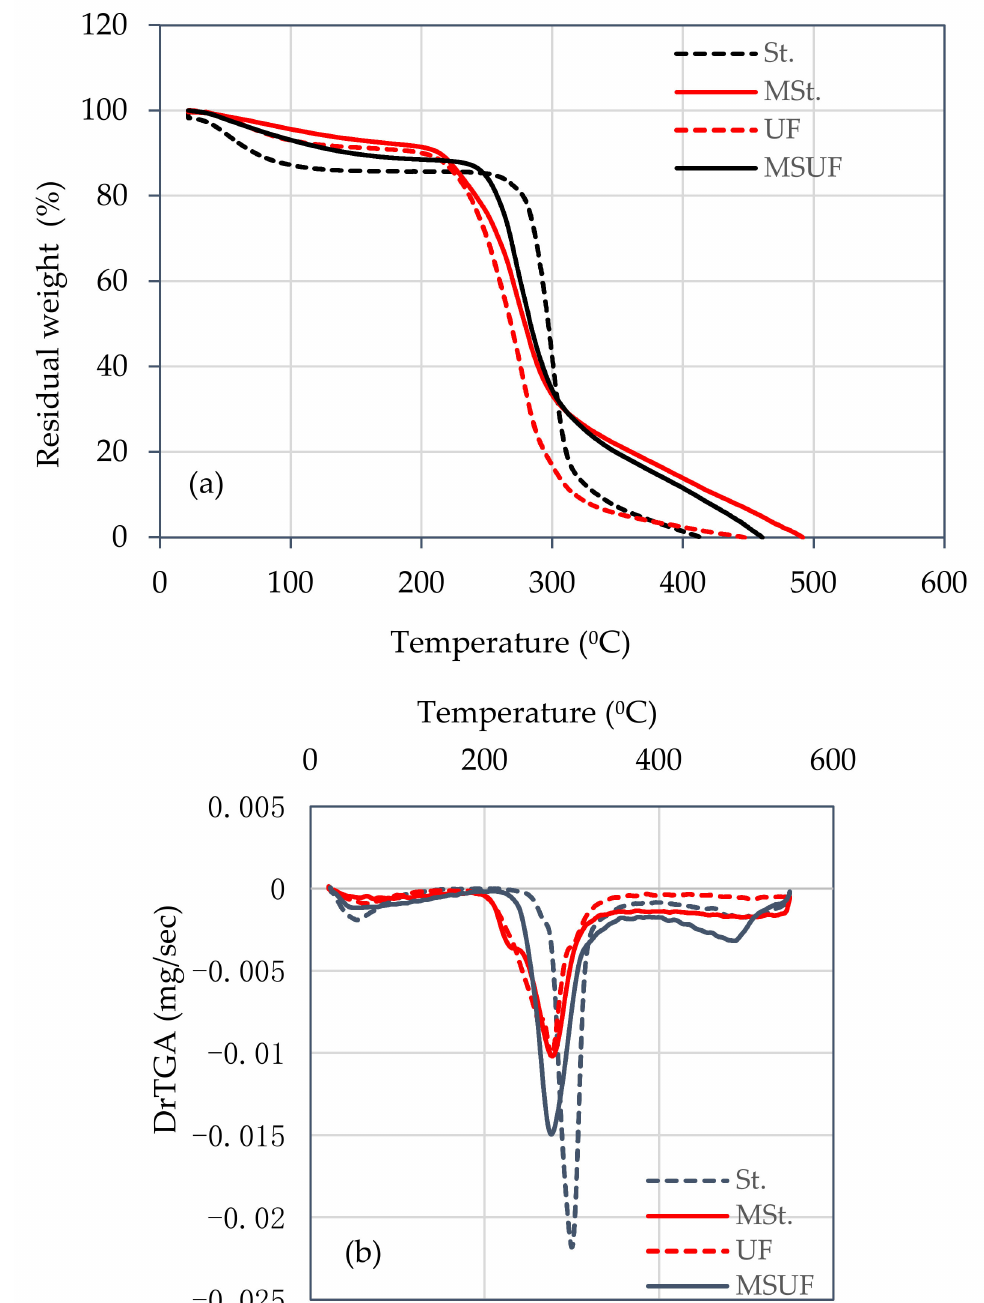
Figure 3. TGA ( a ) and DTG ( b ) curves of natural starch (US), modified starch (MS), UF resin, and UF resin (30%) + modified starch adhesive (70%)